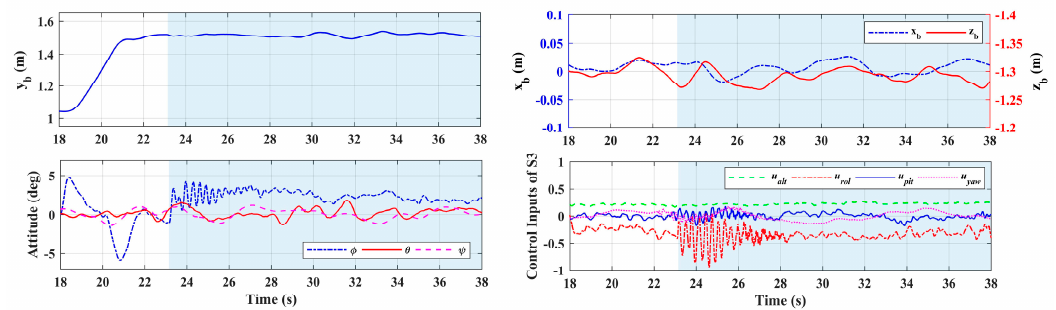
Figure 18. Aerial platform responses in Scenario 3.